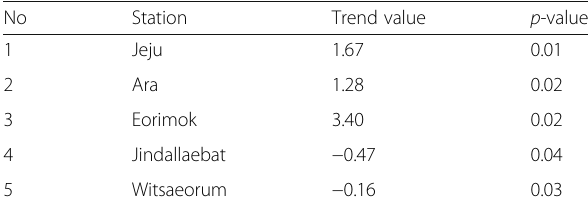
Table 2 Summary of trend analysis of maximum hourly rainfall series using Mann-Kendall